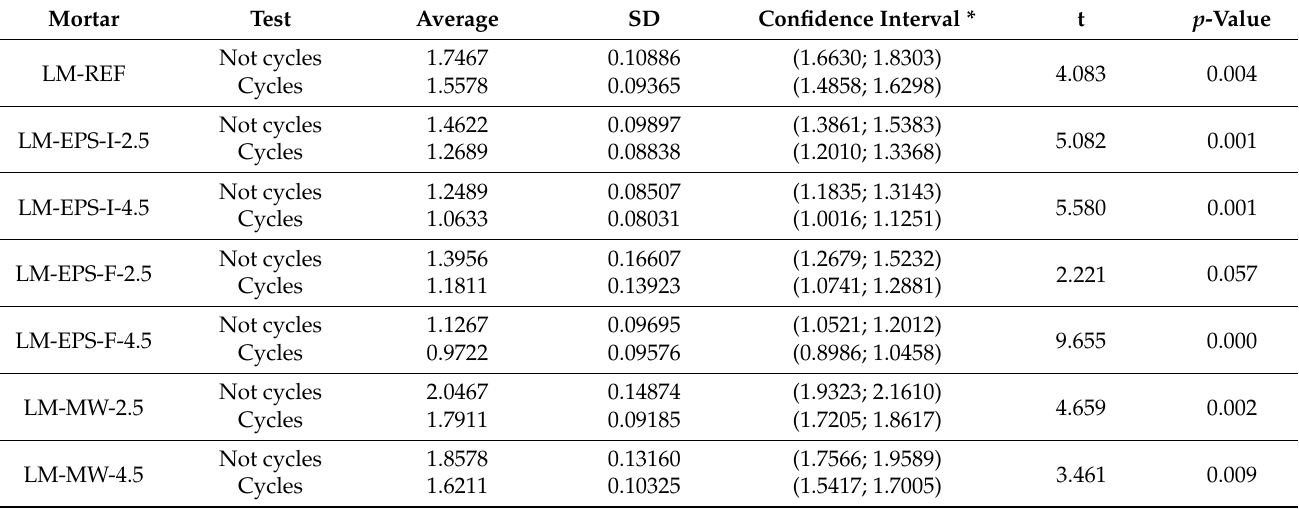
Table 19. Analysis of flexural strength in the freezing test by Student’s t